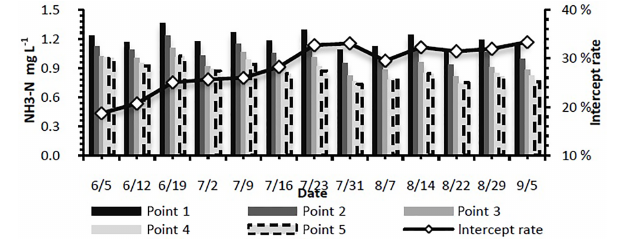
Figure 3. Change laws of the ammonia